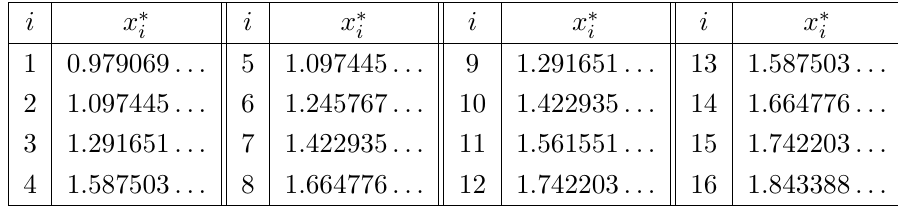
Table 2. Absolute errors obtained by Newton’s method and {(cid:107) F ( x